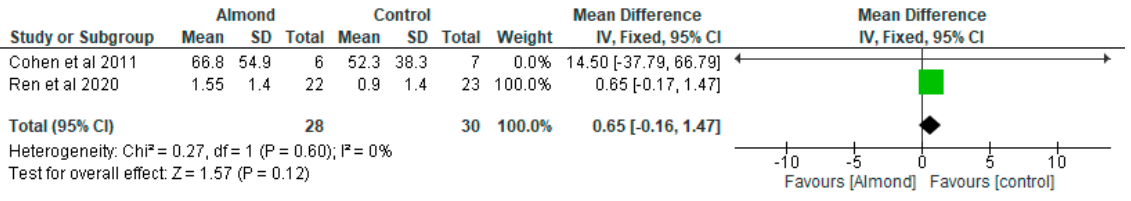
Figure 7. The effect of almond on GLP-1 (pmol/L).